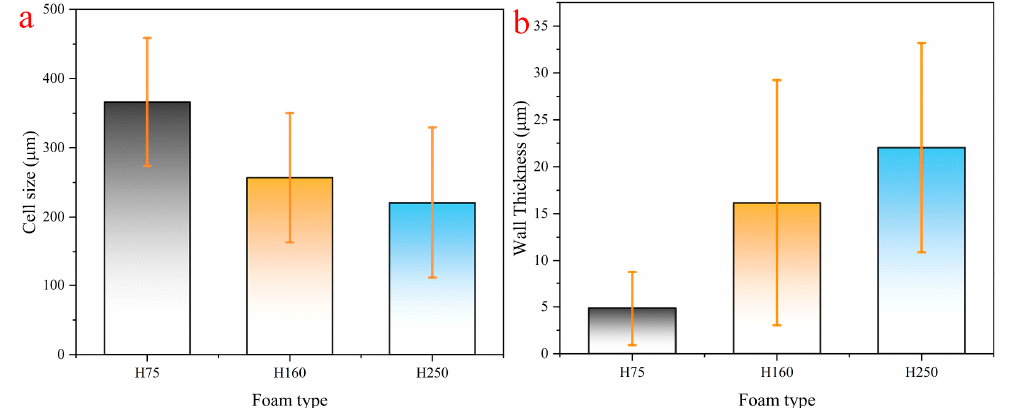
Figure 4. Measurements of PVC foam ( a ) cell size and ( b ) wall thickness.